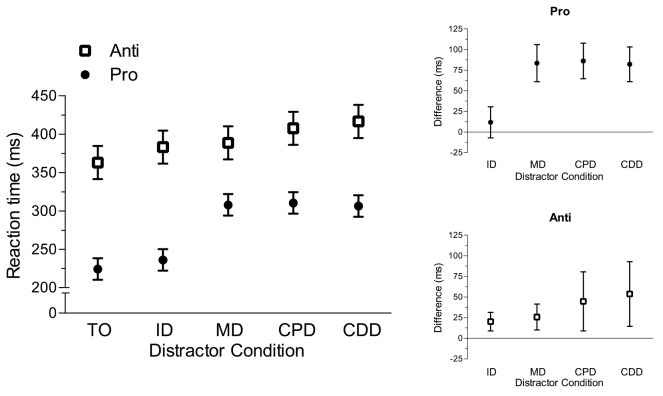
The main panel depicts mean reaction time (ms) for pro- (i.e., closed circles) and antisaccades (i.e., open squares) in target-only (TO), proximal distractor (ID), and remote (MD, CPD, CDD) distractor conditions.Error bars for this panel represent within-participant 95% confidence intervals [28]. Confidence intervals were computed based on the mean-squared error term for trial-type separately for pro- and antisaccades. The top-right and bottom-right offset panels show mean distractor RT difference scores for pro- and antisaccades, respectively. Error bars represent between-participant 95% confidence intervals [29, 30]. The absence of overlap between error bars and zero (i.e., horizontal axis) provides a graphical depiction of a reliable difference that can be interpreted inclusive to a test of the null hypothesis.